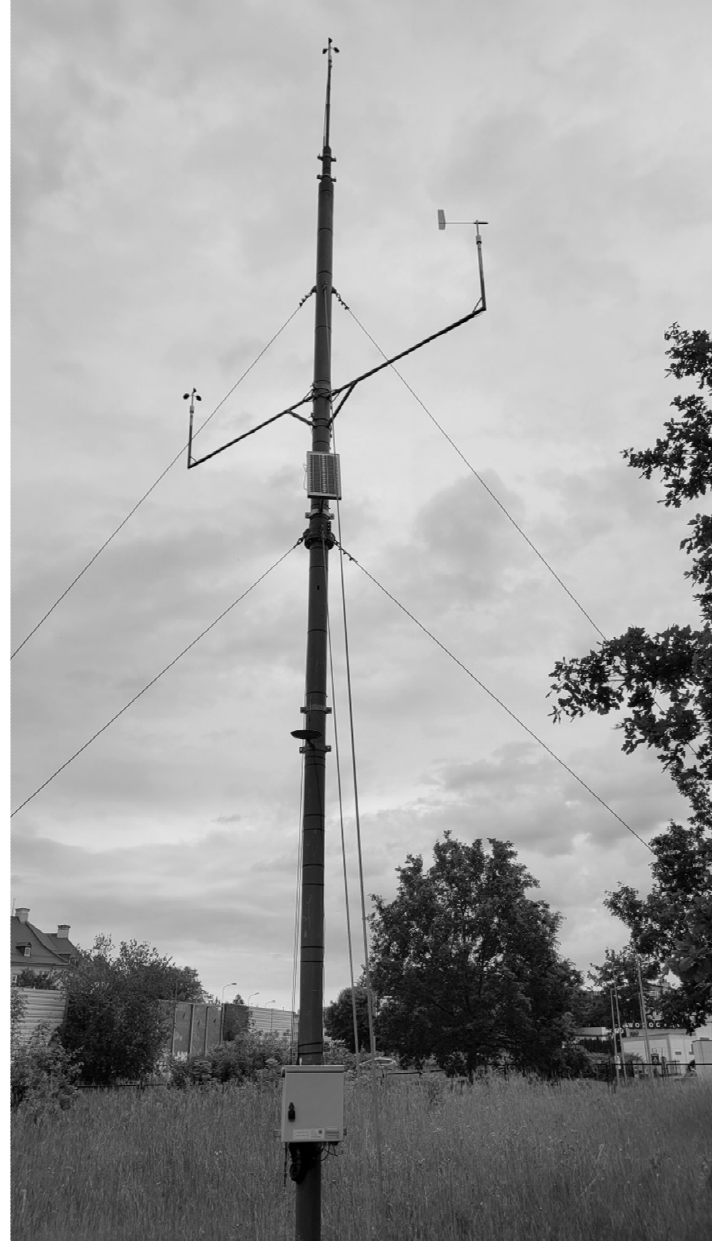
Figure 3. View of the measuring mast.